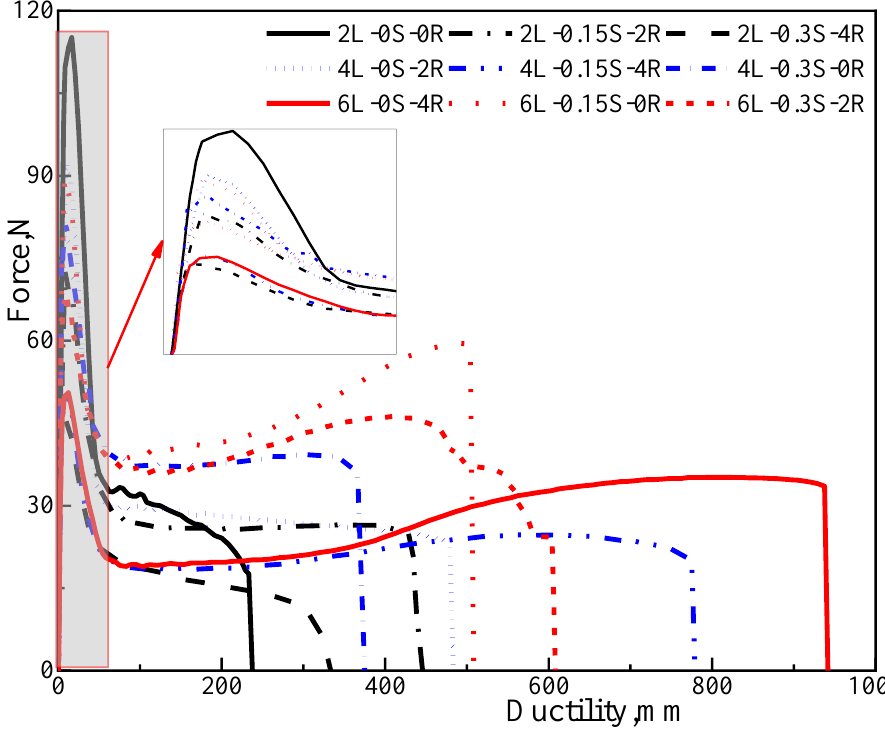
Figure 6. Force-ductility curves for nine different types of polymer modified bitumen. Figure 6. Force‑ductility curves for nine different types of polymer modified